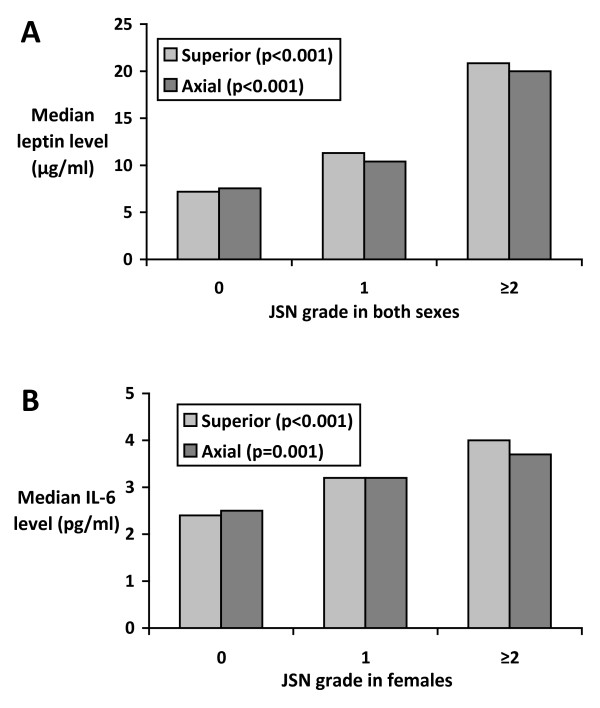
Associations between hip-joint-space narrowing (JSN). (a) Leptin in both sexes. (b) Interleukin (IL)-6 in women only. Statistical significance calculated by univariable ordinal regression.